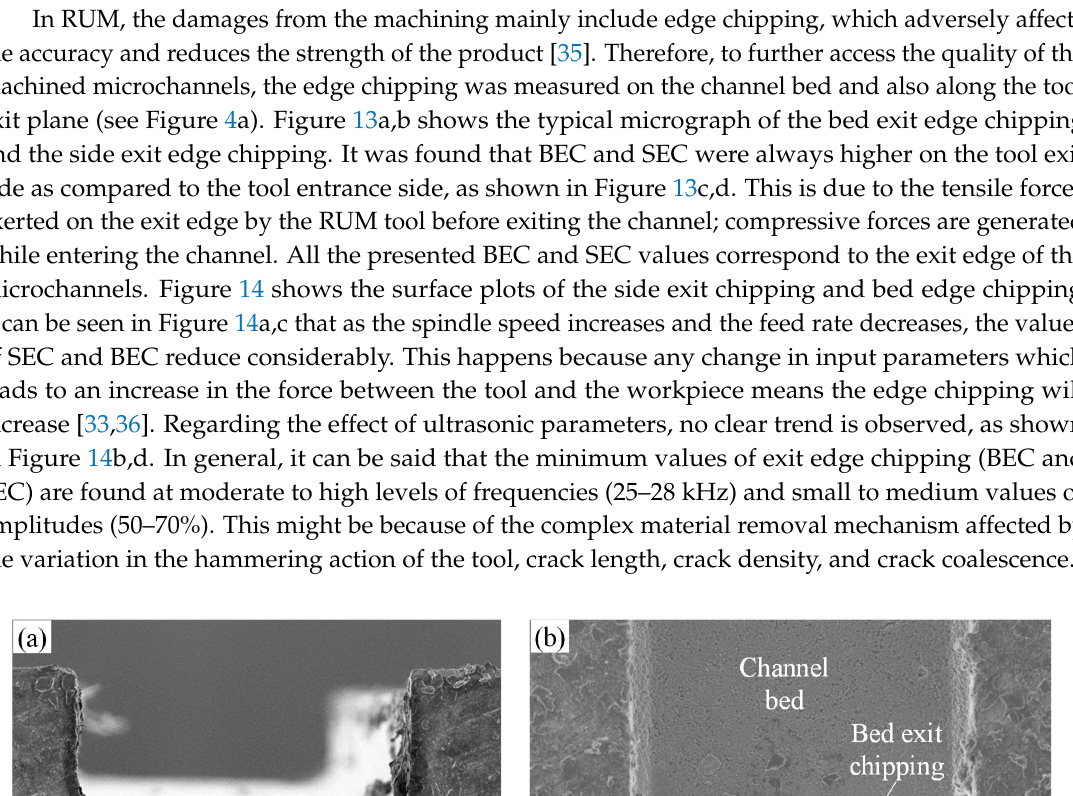
Figure 14. Response surface plots, i.e., effects of the indicated process parameters on ( a ) and ( b ) SEC, and ( c ) and ( d ) BEC.